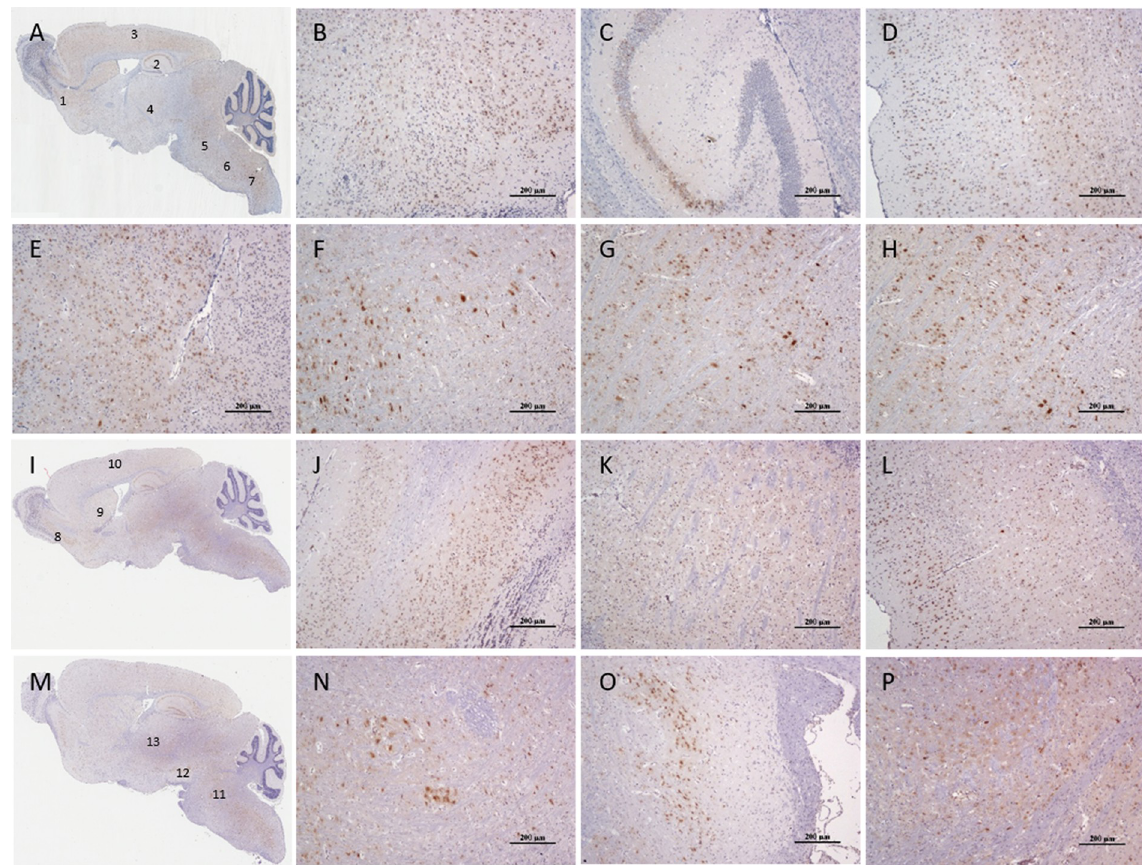
Fig 5. Localization of virus in mouse cranial nerve nuclei at 6 d post JEV infection. (A, I, M) The distance of the parallel brain sections from the mid-sagittal plane were 0.72 mm, 0.96 mm, and 1.32 mm, respectively. The enlarged images at 1–13 sites correspond to immunohistochemical staining of the JEV antigen in (B) AOV, AOP, and AOM; (C) CA3, CA2, and Py; (D) M2; (E) VL, VM, and VPM; (F) PnO and PnC; (G) Gi; (H) MdV; (J) AOV, AOP, and AOD; (K) CPu; (L) M1; (N) Mo5; (O) SNC and SNR; (P) Rt and